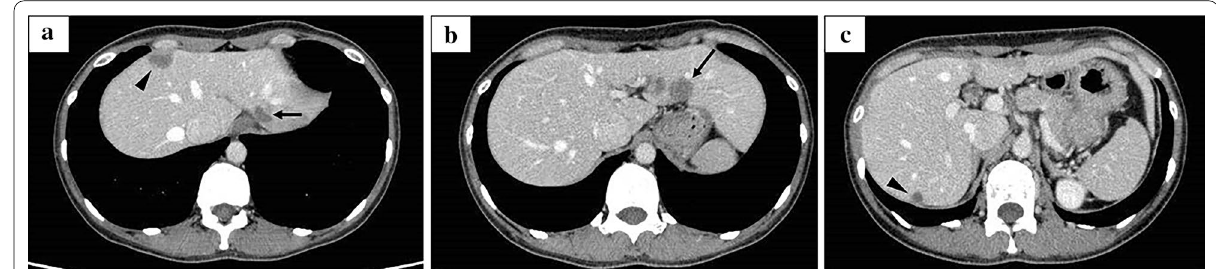
Fig. 1 a – c Abdominal contrast-enhanced computed tomography showed four hypovascular liver tumors in the left lateral section ( a and b , arrow), the posterior superior segment (S7) ( c , arrowhead), and the anterior superior segment (S8) (Fig. 1a, arrowhead)